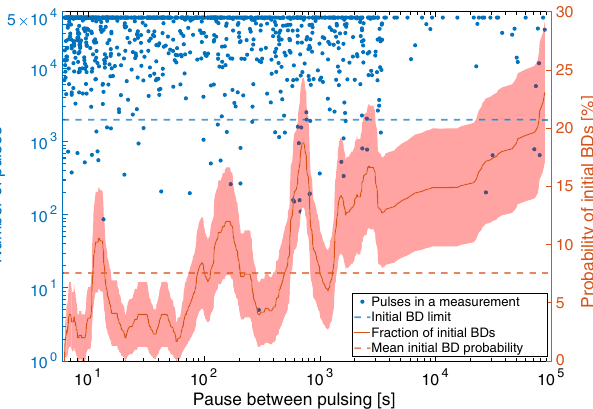
FIG. 11. Blue dots show the number of pulses in a pulsing run with no ramping, after a pause of random length. The solid orange line shows the moving average of the initial BD percentage [fraction of runs that resulted in a BD in less than 2000 pulses (blue dashed line)]. The red shaded area shows the uncertainty of the initial BD percentage as the standard error of the mean, and the orange dashed line shows its mean